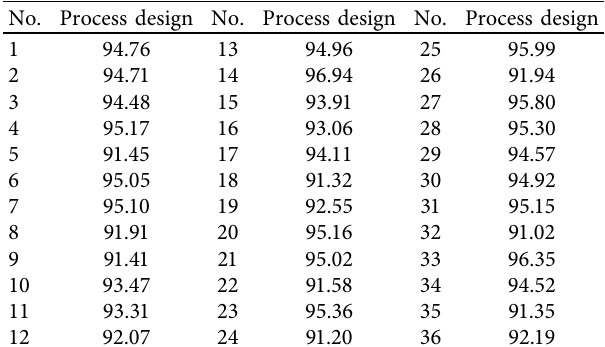
Table 6: Process design